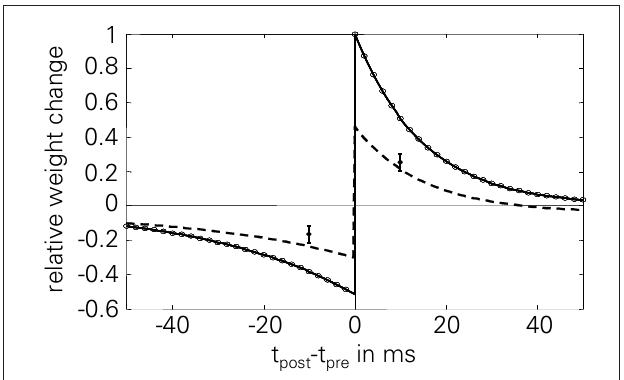
FigurE 4 | Normalized STDP window of LCP with SrM: analytical value (solid line) and simulation results (circles, 60 pairings at 1 hz, ∆ w ∞ protocol of Bi and Poo, 1998; Froemke and Dan, 2002). STDP parameters are taken from Froemke and Dan (2002) and corrected by the number of repetitions, cf. Froemke 1 parameter set in Table 4 . Error bars are measurements from Wang et al. (2005), as extracted by Pfister and Gerstner (2006); dashed line: simulation results for Wang parameter set, used to account for the smaller weight changes found throughout the experiments in Wang et al. (2005), as stated there. Normalized error in this case: E =